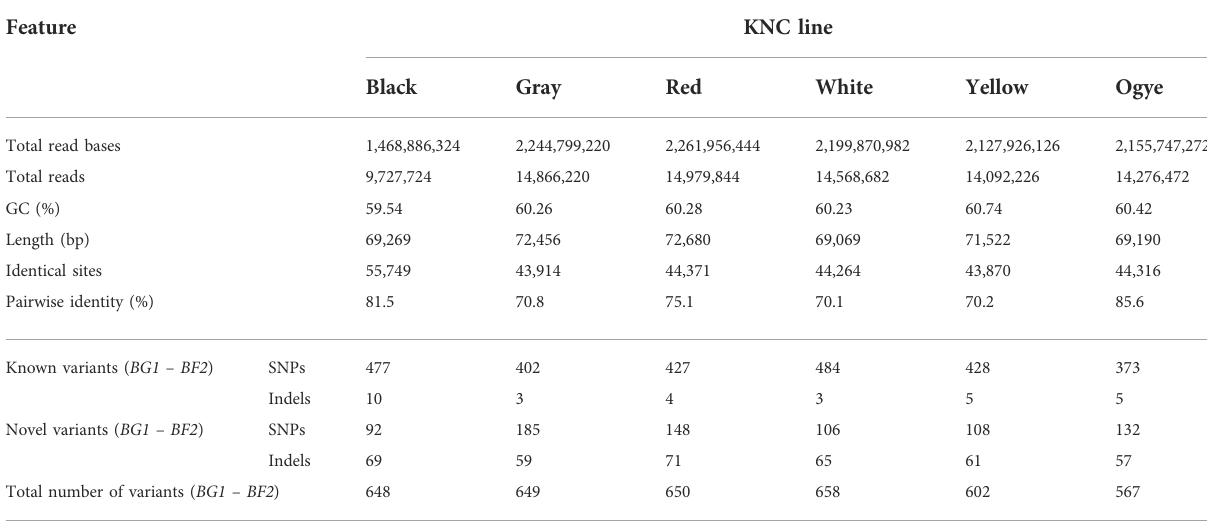
TABLE 1 Raw NGS data and assembly statistics for six KNC lines with known and novel variants obtained for the MHC- B region (variants with an Ensembl-based rs-number were considered known variants).